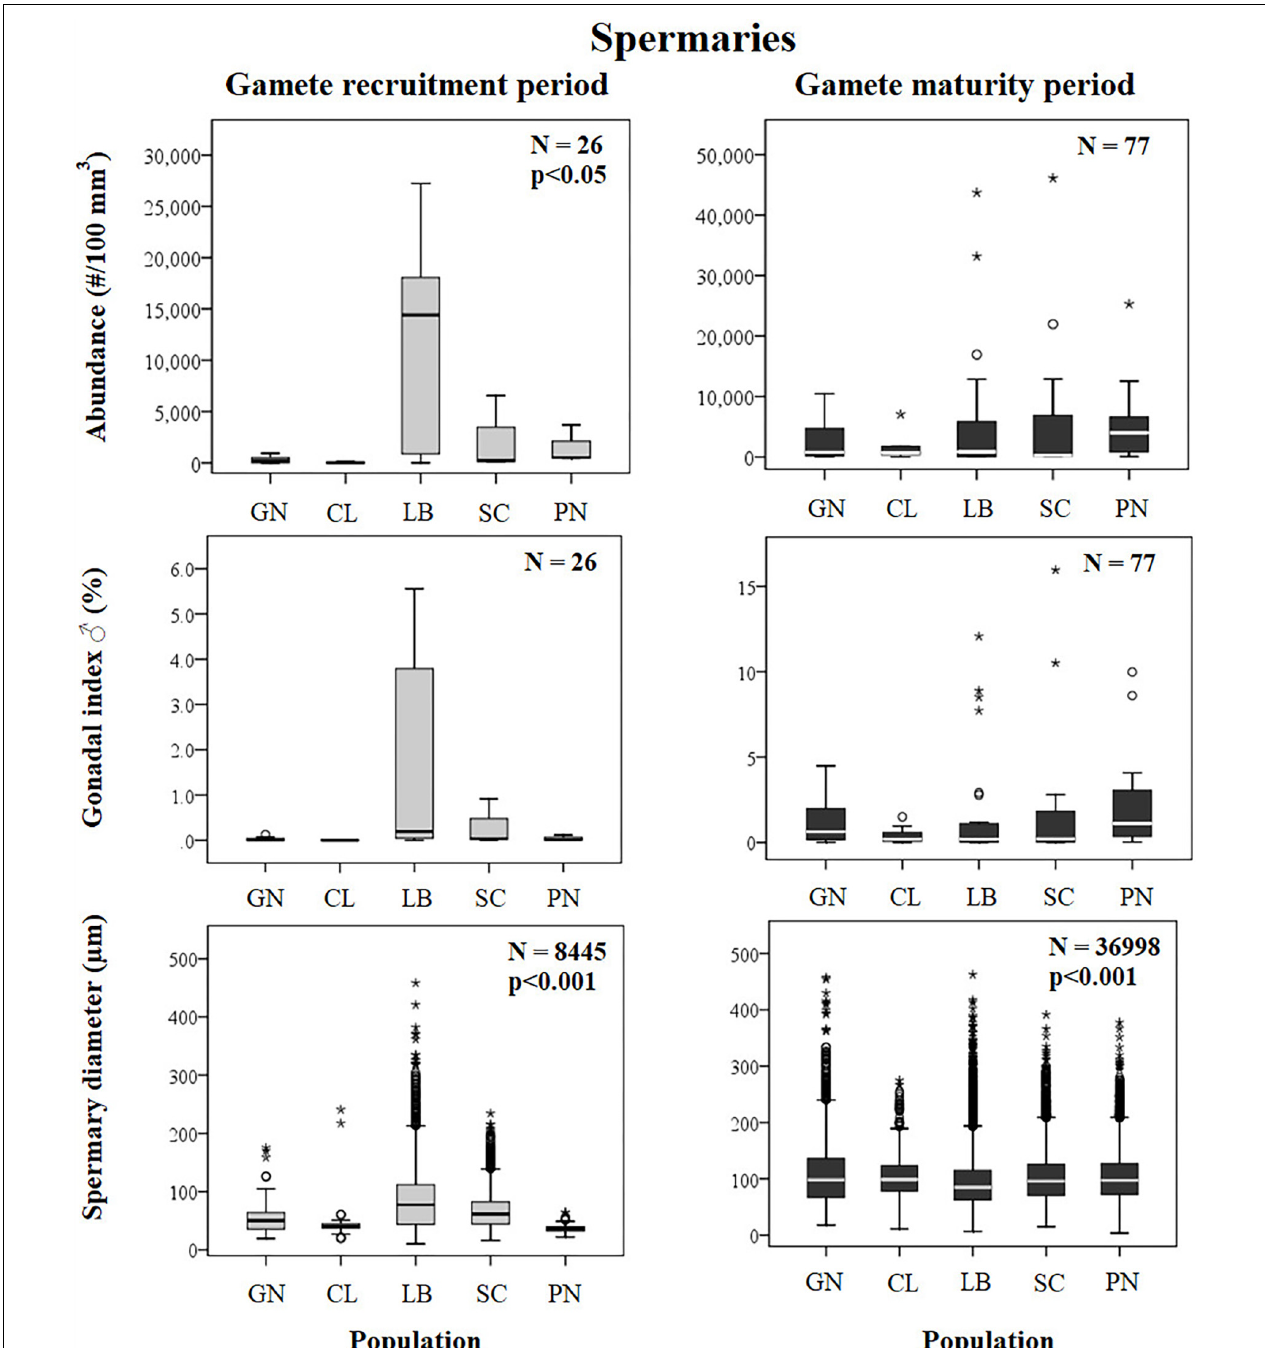
FIGURE 6 | Spermaries. Boxplots of reproductive parameters per study site (GN Genova; CL Calafuria; LB Elba Island; SC Scilla; PN Pantelleria Island) during the gamete recruitment and gamete maturity periods. Each boxplot diagram shows the median (solid horizontal line), the first and third quartiles (box outline), the minimum and maximum values (whiskers) and the outliers (stars and circles). N , polyp number for abundance and gonadal index, spermary number for diameter; p , significance of the ANOVA/Kruskal–Wallis